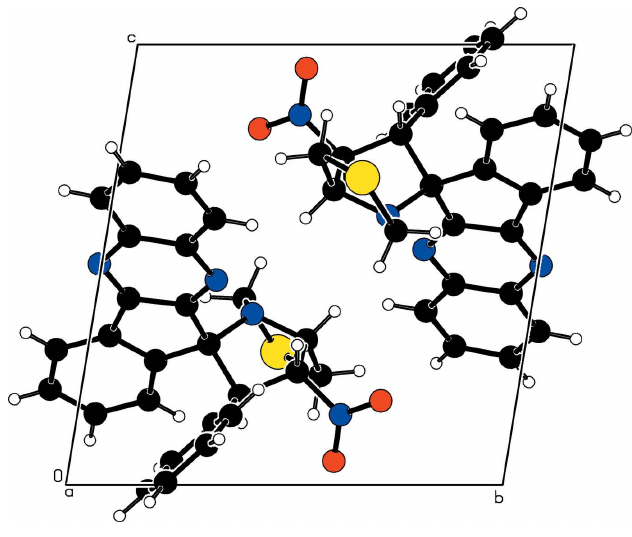
Figure 2 Packing diagram of the title compound viewed down the a axis. Hydrogen bonds (Table 1) are shown as dashed lines. H bonds not shown